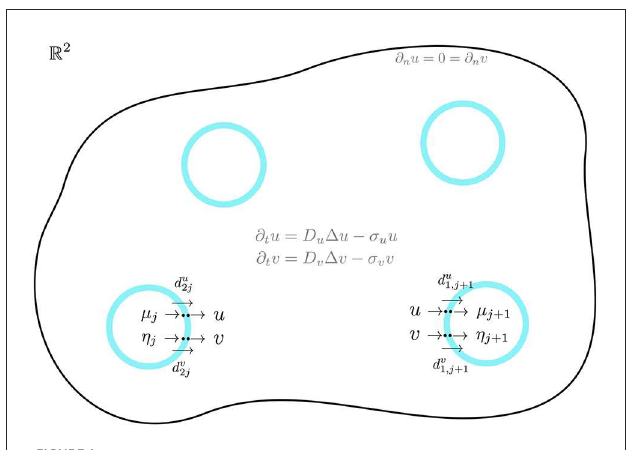
FIGURE1 A 2-D bounded domain with four diffusion-coupled circular cells of a common radius. In the j th cell, activator-inhibitor reaction kinetics occur for the activator µ j and inhibitor η j . Across the cell membrane, there is an exchange between the intracellular and bulk species. In the bulk, u and v diffuse and undergo degradation. The cells are assumed to be small but are drawn larger here for illustration